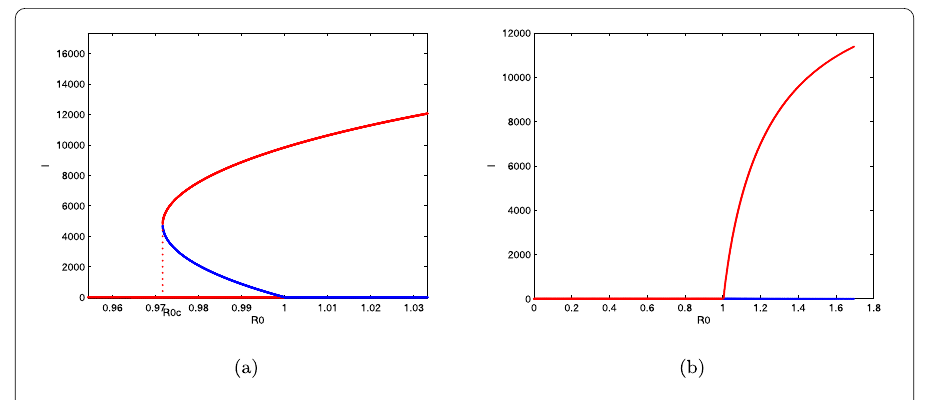
Figure 6 Bifurcation diagram in ( R 0 , I ) plane. (a) Backward bifurcation (0.81 ≤ α ≤ 0.86). (b) Forward bifurcation (0.2 ≤ α ≤ 0.7).